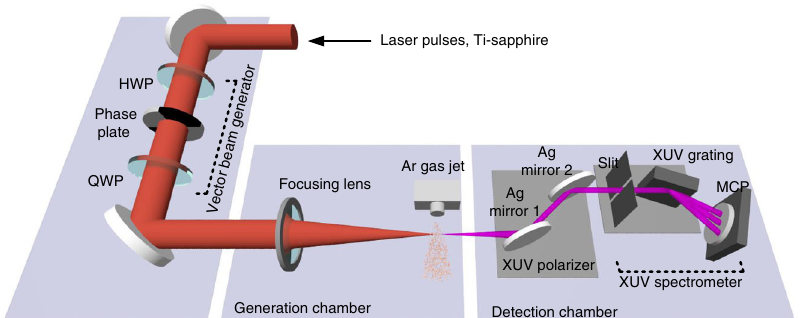
Fig. 2 Experimental setup for measuring XUV polarization using an XUV polarizer. The linearly polarized driving laser beam is prepared by going through a half-wave plate, a designed phase plate shown in Fig. 1a and a quarter-wave plate to convert into circular state. It is then focused by a 30 cm lens into a vacuum chamber to interact with argon noble gas. The generated XUV radiation propagates through a XUV linear polarizer placed 50 cm from the gas jet and in the far fi eld for the XUV light. The re fl ectivity of a silver mirror in the XUV is polarization dependent. With a 23-degree angle of incidence to a pair of silver mirrors we construct a XUV polarizer in front of a XUV spectrometer to select one linearly polarized